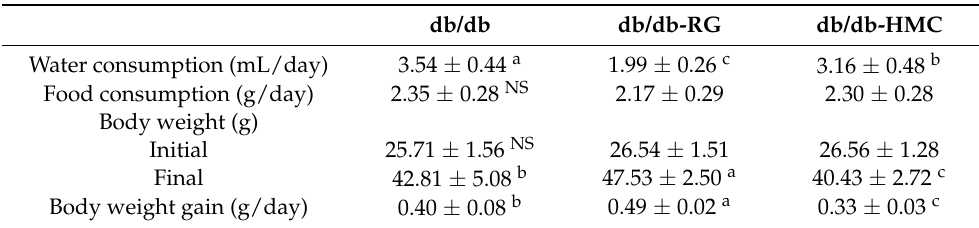
Table 1. The effects of HMC administration on body weight, food and water consumption of C57bl/ksj-db/db